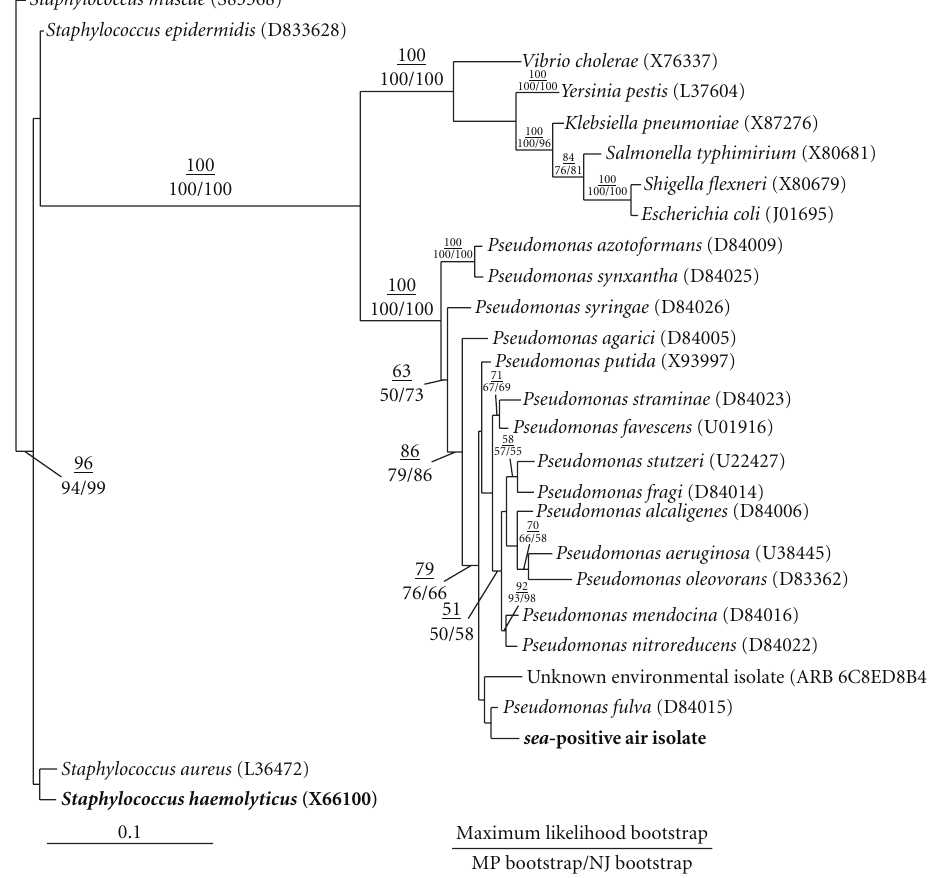
Figure 1: Phylogenetic tree of sea -positive isolate, its nearest relatives, and select outgroups. PAUP ∗ was used to generate a consensus phylogenetic tree. Maximum Likelihood (ML) analysis was performed using 100 replicates with 10 random addition sequences searches per replicate. Maximum Parsimony (MP) analysis was performed using searches on 100 bootstrap replicated datasets with 10 search replicates. The Neighbor-joining (NJ) bootstrap analysis was performed with 1000 replicates. The (ML bootstrap)/(MP bootstrap/NJ bootstrap) values are as indicated. The sea -positive isolate is highlighted in bold and GenBank Accession numbers of each organism are in